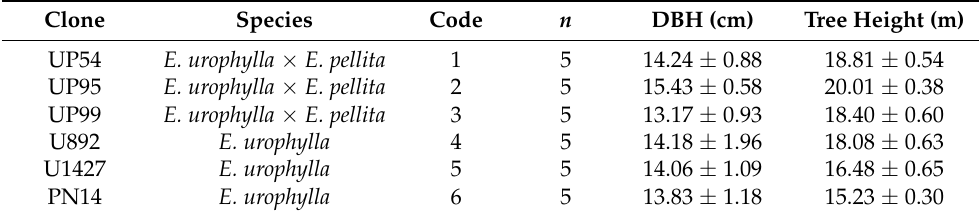
Table 1. Mean values and standard deviations of stem diameter and tree height for each clone.